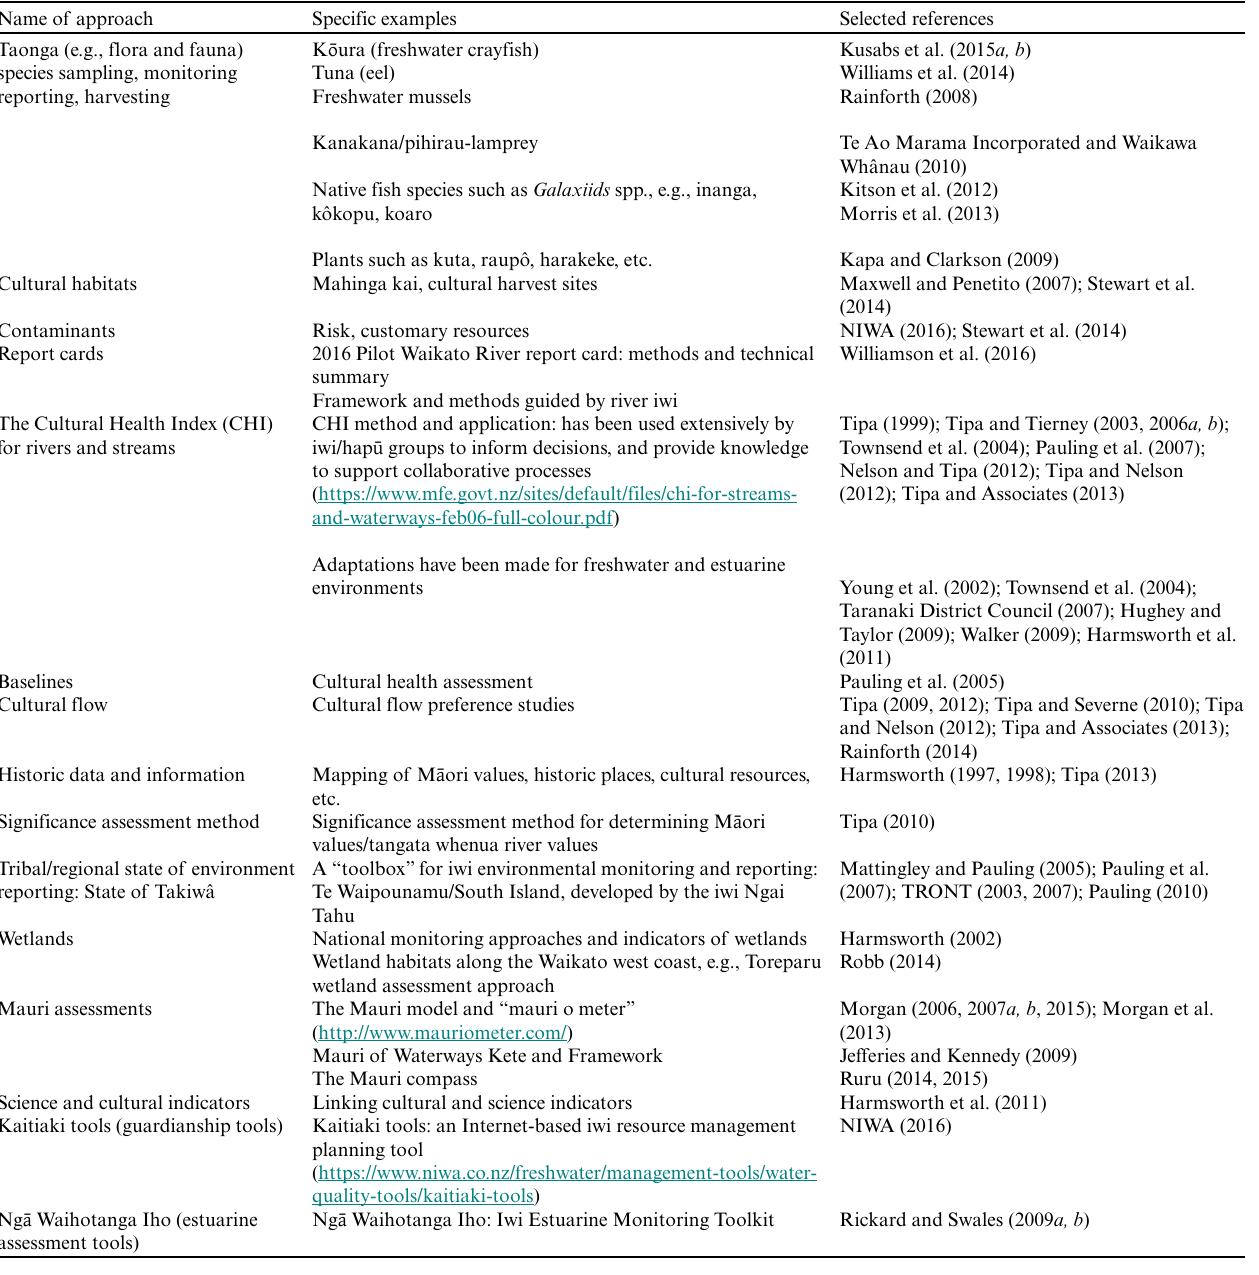
Table 1 . Key M ā ori-led cultural monitoring approaches in Aotearoa-New Zealand Name of